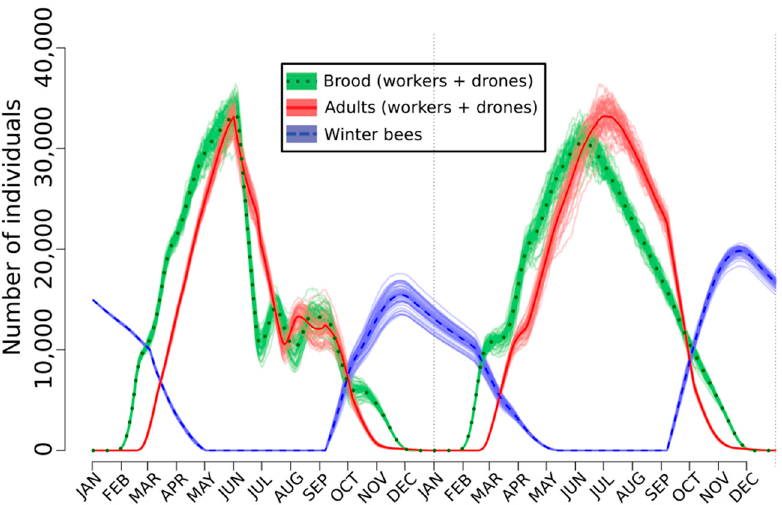
Figure 1. Effect of the rejection of the emergent bees on the population dynamics of A. mellifera simulated with the agent ‐ based model SimBeePop.